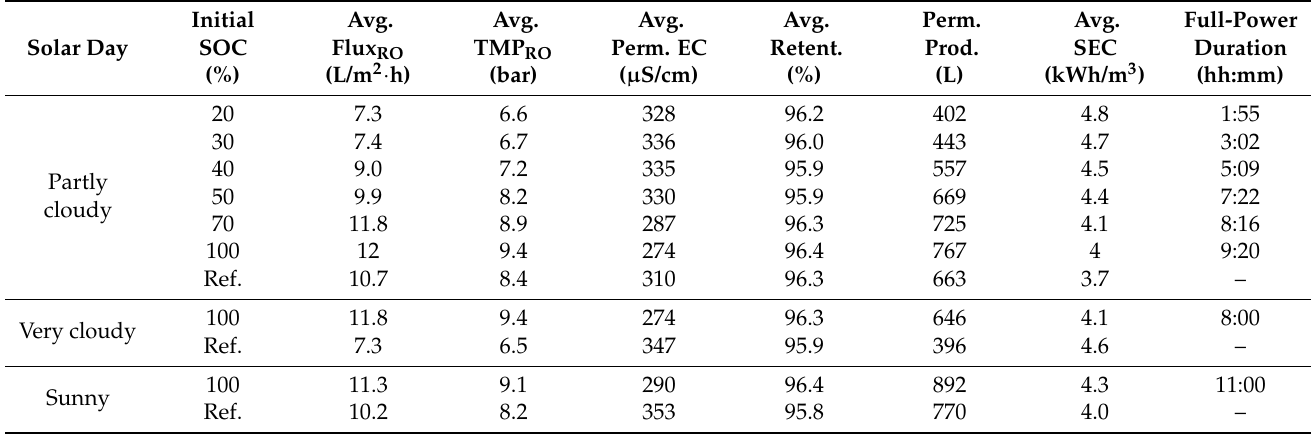
Table 1. The overall average performance of the photovoltaic (PV)-membrane system with/without batteries over the three “solar days”. Flux RO : flux of RO membrane, TMP RO : transmembrane pressure of RO membrane, SOC: state-of-charge and EC: electrical